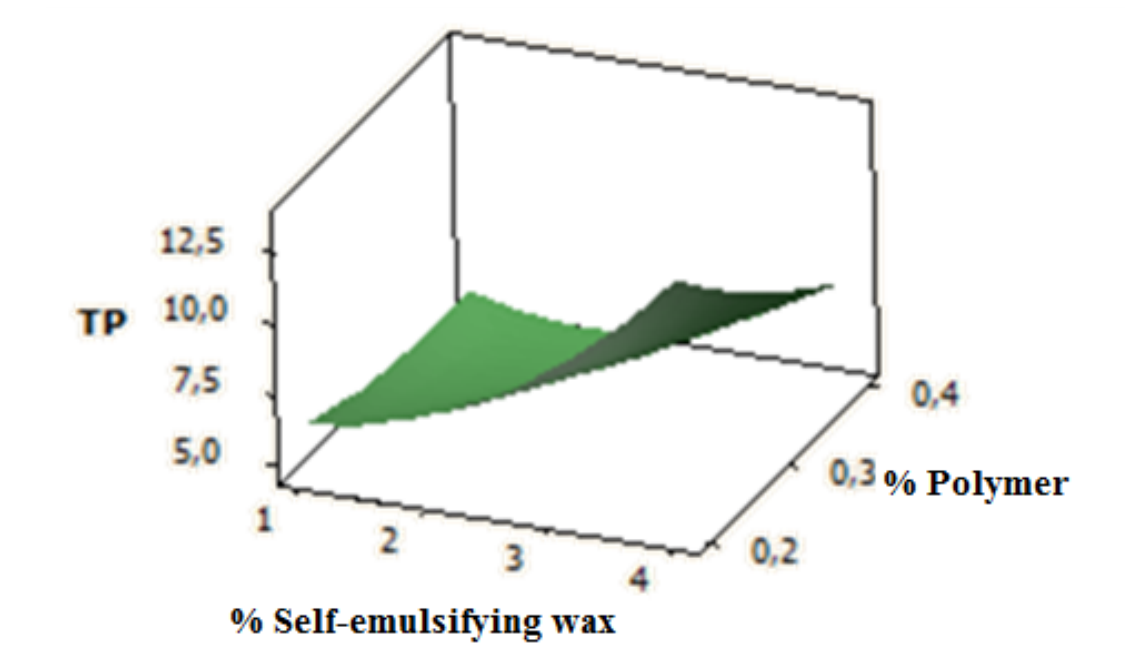
FIGURE 5 - Response surfaces for particle size (TP) as a function of the factors: % of self-emulsifying wax and % hydrophilic polymer for the formulation containing 0.1%